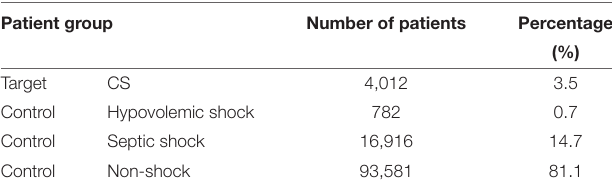
TABLE 4 | Number of patients in the target group (CS) and the control group (septic/hypovolemic shock and non-shock) after excluding patients with diagnosis of multiple shock